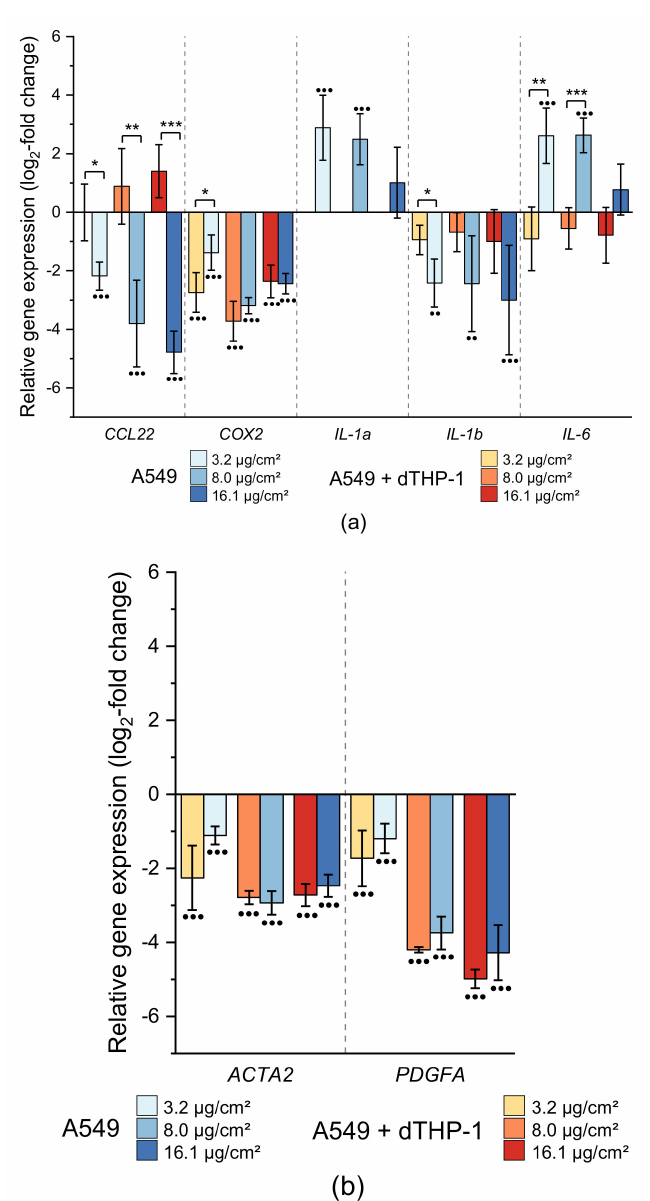
Figure 5. Impact of CuO NP on genes related to inflammation and fibrosis in A549 monoculture (A549) and co-culture (A549+dTHP-1) after 24 h incubation. ( a ) Gene expression of inflammatory markers; ( b ) gene expression of fibrotic markers. Depicted are the log 2 -fold changes of at least three independently conducted experiments ± SD. Significantly different from negative